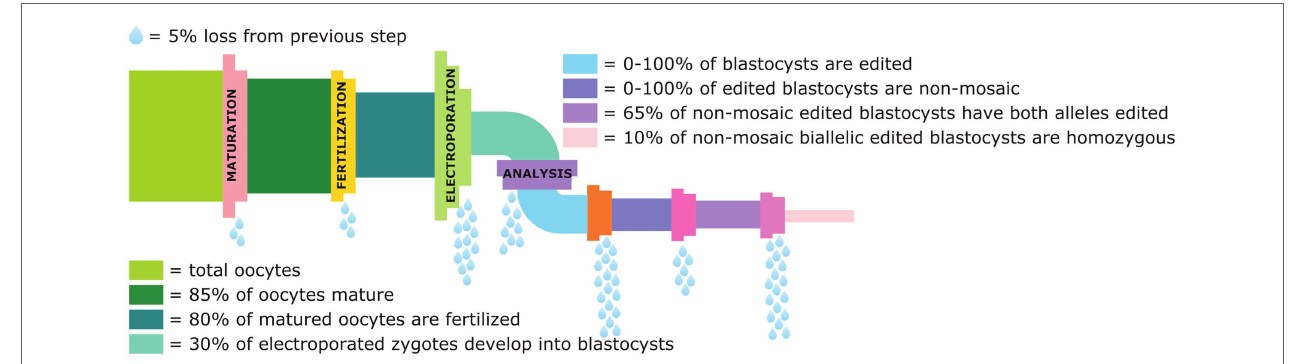
FIGURE 3 | Graphical representation of the losses in the genome editing pipeline from collection of oocytes to the percentage of blastocysts that are non-mosaic homozygotes for the intended edit. Data derived from Remy et al. (2017), Teixeira et al. (2018), and Miao et al.